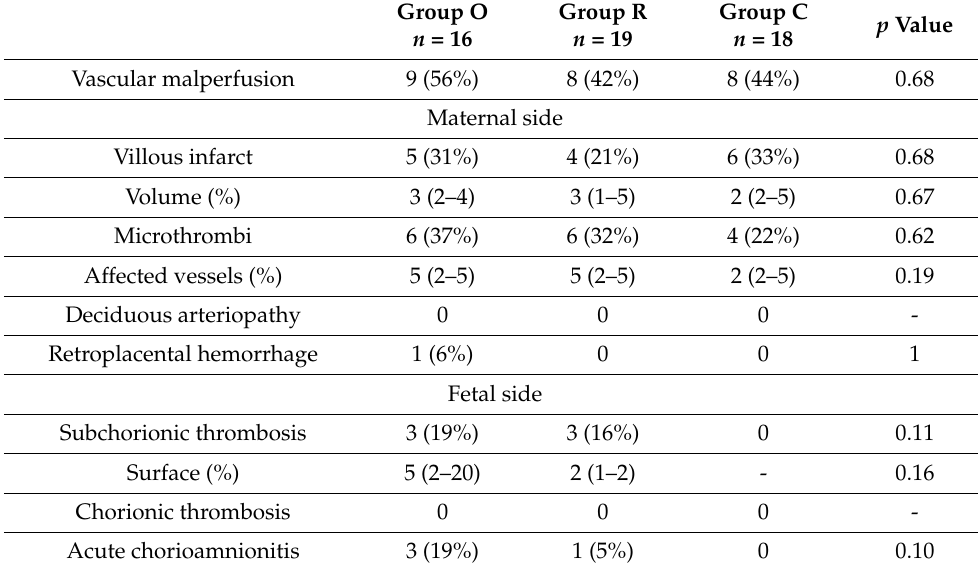
Table 2. Placenta histopathologic analysis.